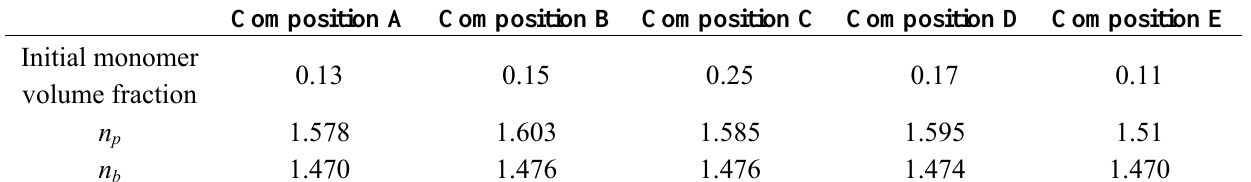
Table 4. Initial monomer volume fraction, polymer refractive index, n refractive index, n , for each composition based on b